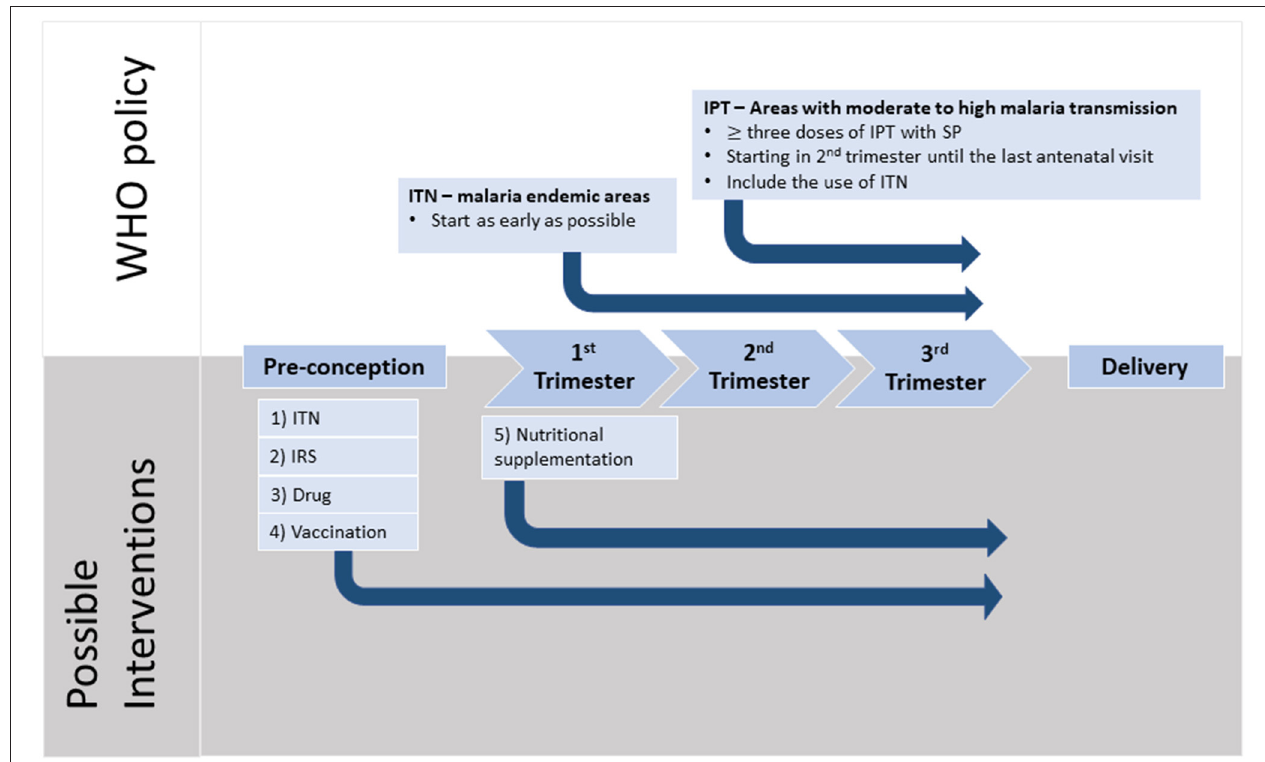
FIGURE 2 | Timeline of pregnancy events with WHO recommendations and possible interventions. Malaria in pregnancy (MiP) is preventable and the current WHO recommendations for Africa include three or more doses of intermittent preventive treatment during pregnancy (IPT) with sulfadoxine-pyrimethamine (SP) taken one month apart starting from fetus quickening. In addition, sleeping under insecticide treated nets (ITNs) has been shown to reduce parasite burden during pregnancy. Strong evidence indicates that MiP starts during the first trimester with irreversible damage and it is during this period of time that pregnant mothers are at the highest risk of parasitemia. Furthermore, recent evidence suggests that women often harbor parasites before conception, and these parasites may switch to a placental-binding phenotype, that is likely to contribute to placental inflammation, especially in women pregnant for the first time. We propose several potential interventions which may help to alleviate the harmful impact of MiP. (1) ITNs should be used from early pregnancy, or before conception, to reduce the risk of acquiring new infections. (2) Indoor residual spraying should be evaluated for its effectiveness against MiP. (3) Pre-pregnancy intermittent screening for malaria, with treatment by safe and effective drugs, should be considered. (4) Pregnant women need access to an effective vaccine that can induce protection against MiP. Currently, there are two vaccines that are in clinical trials. (5) The nutritional status of the mother should be optimized during pregnancy with appropriate micro- or macronutrient supplements to ensure optimal placental development and thus better birth